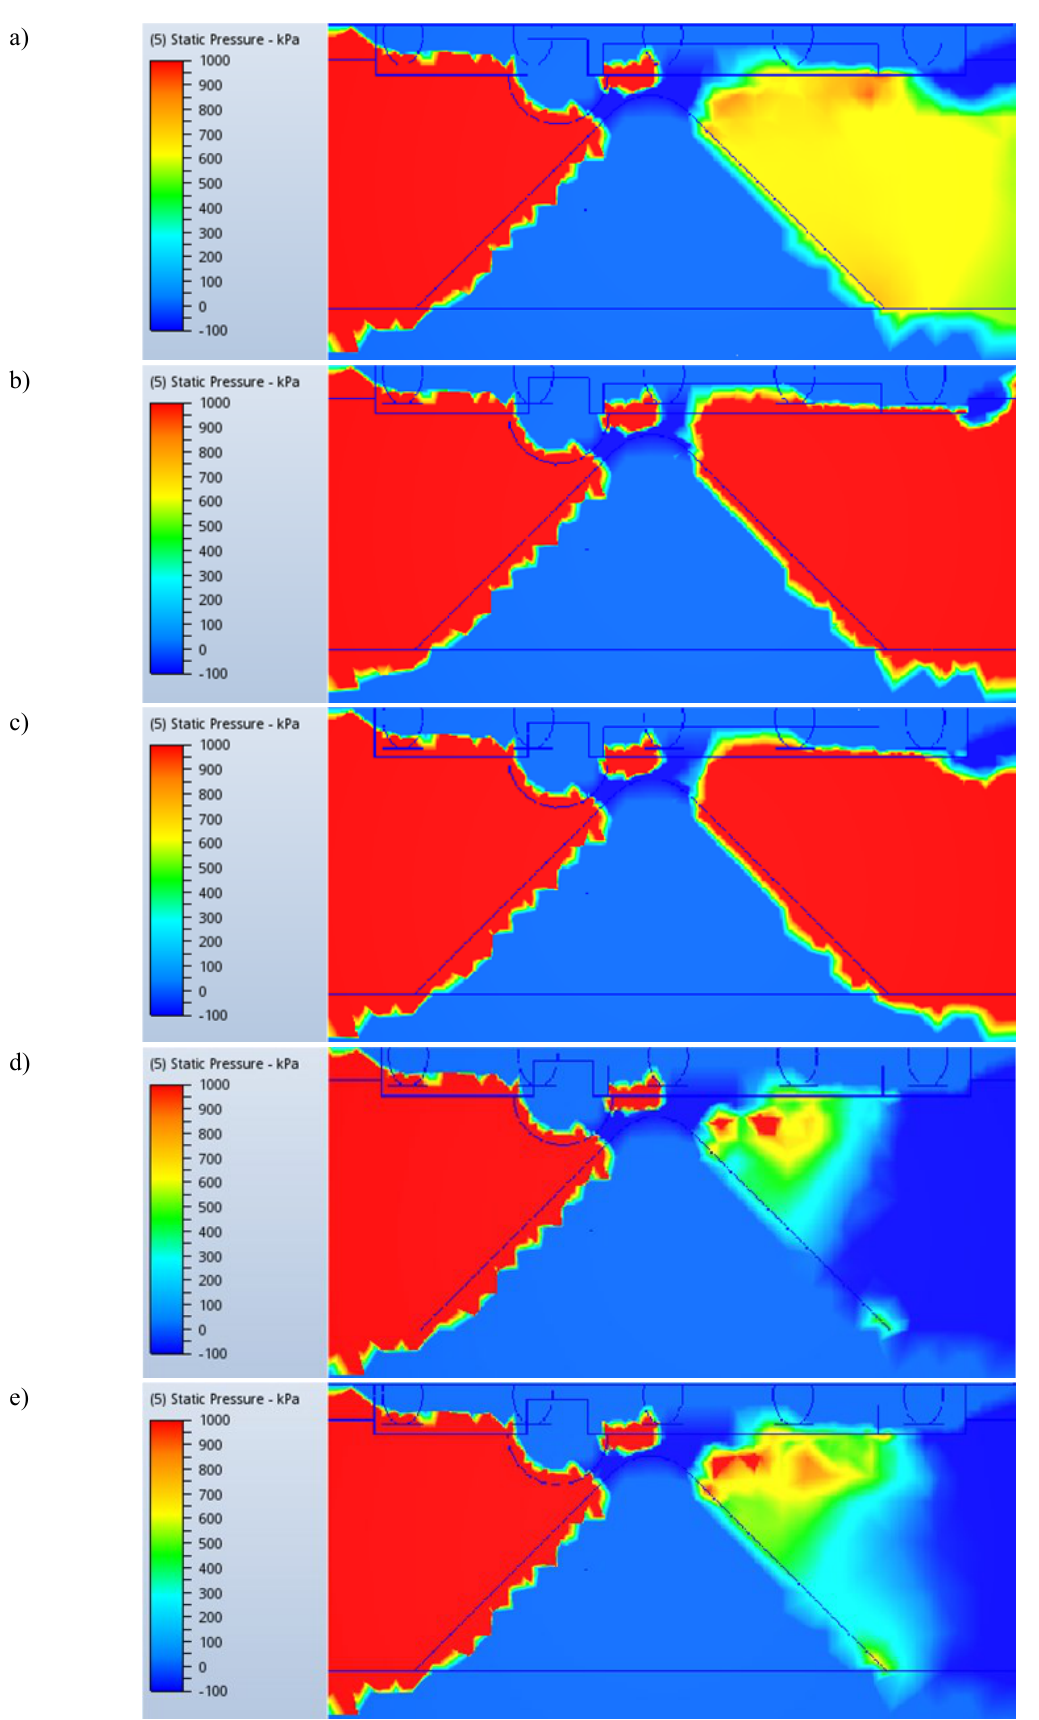
Fig. 7. The results of the pressure in the tunnel for the flow rate in the tunnel inlet: a) 7,74 m/s, b) 8,85 m/s, c) 9,95 m/s, d) 11,06 m/s, e) 12,16